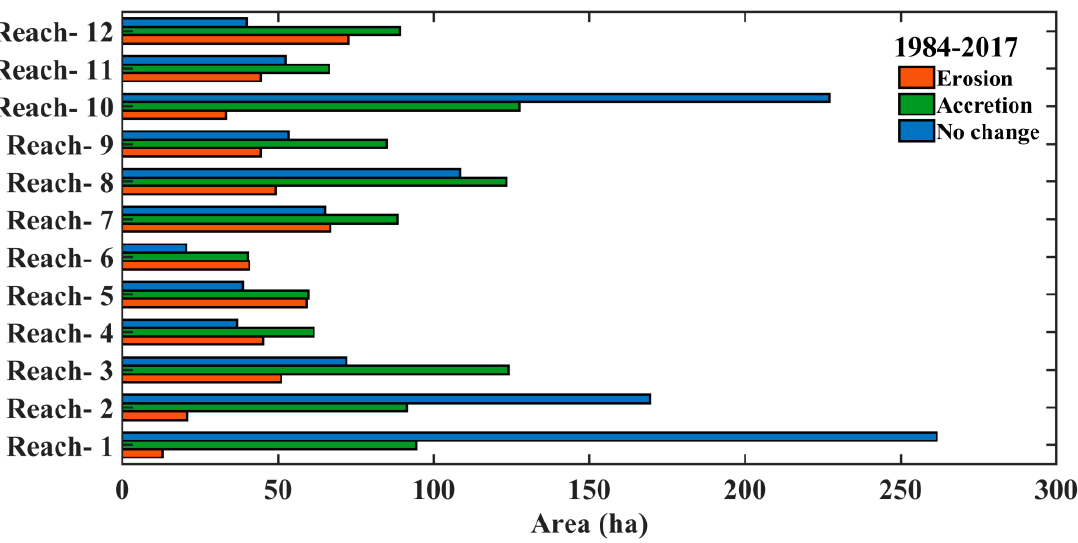
Figure 14. Erosion, accretion, and unchanged area at various reaches (1–12) between